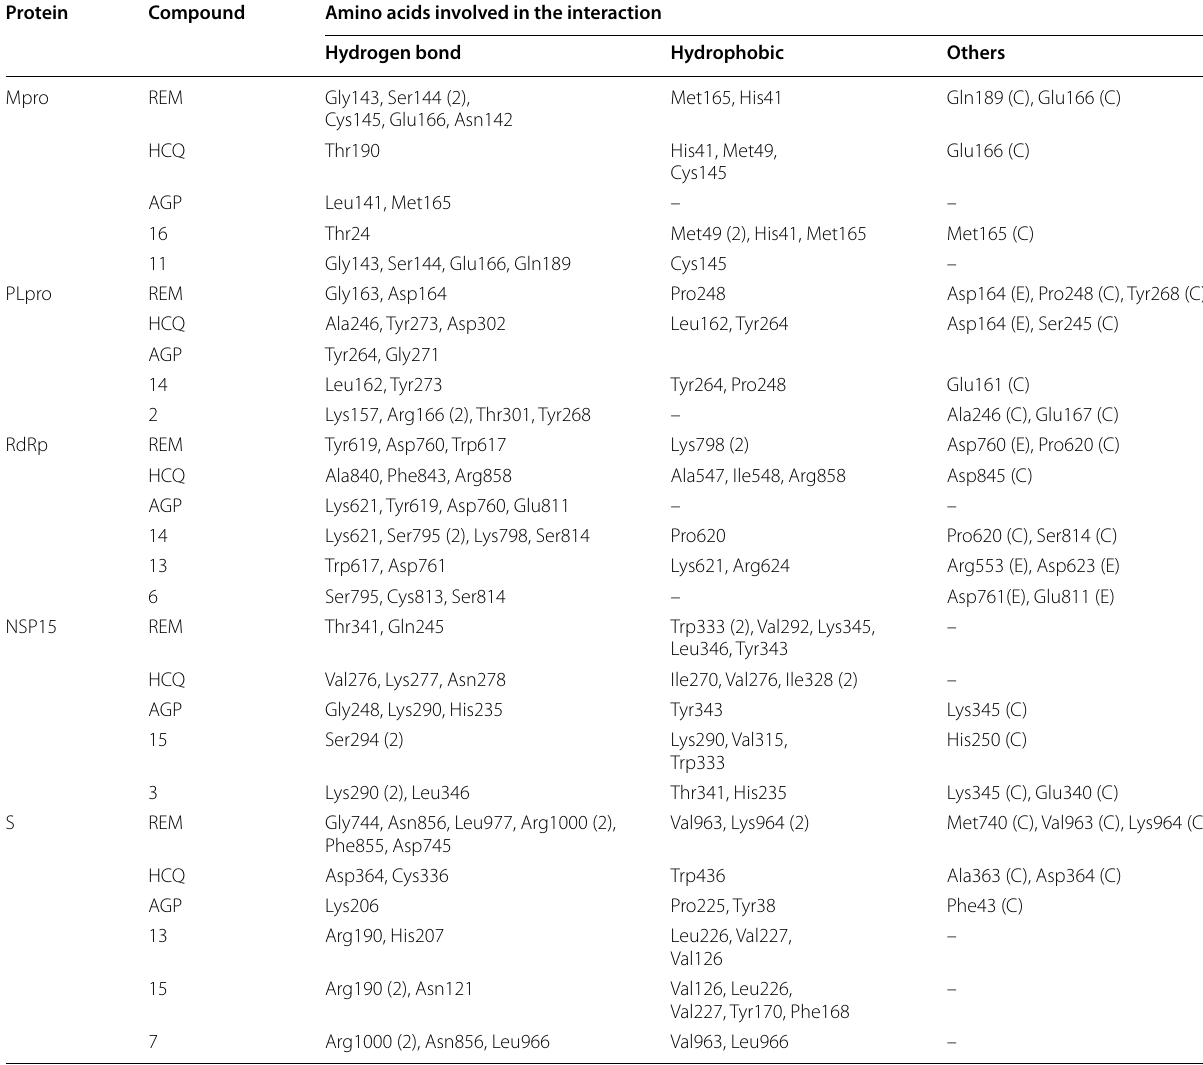
E electrostatic, S pi-sulfur bond, C carbon-hydrogen bond Numerical value in the parenthesis next to amino acid residue indicates the number of interactions of that